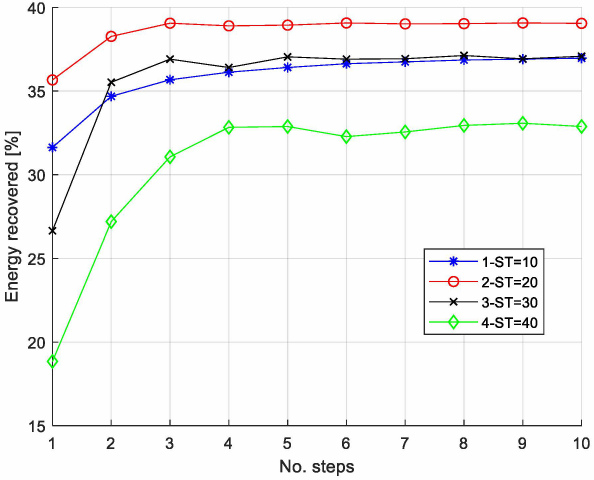
Figure 9. Fraction of energy recovered, starting at 50 km/h for stopping times from 10 to 40 s.